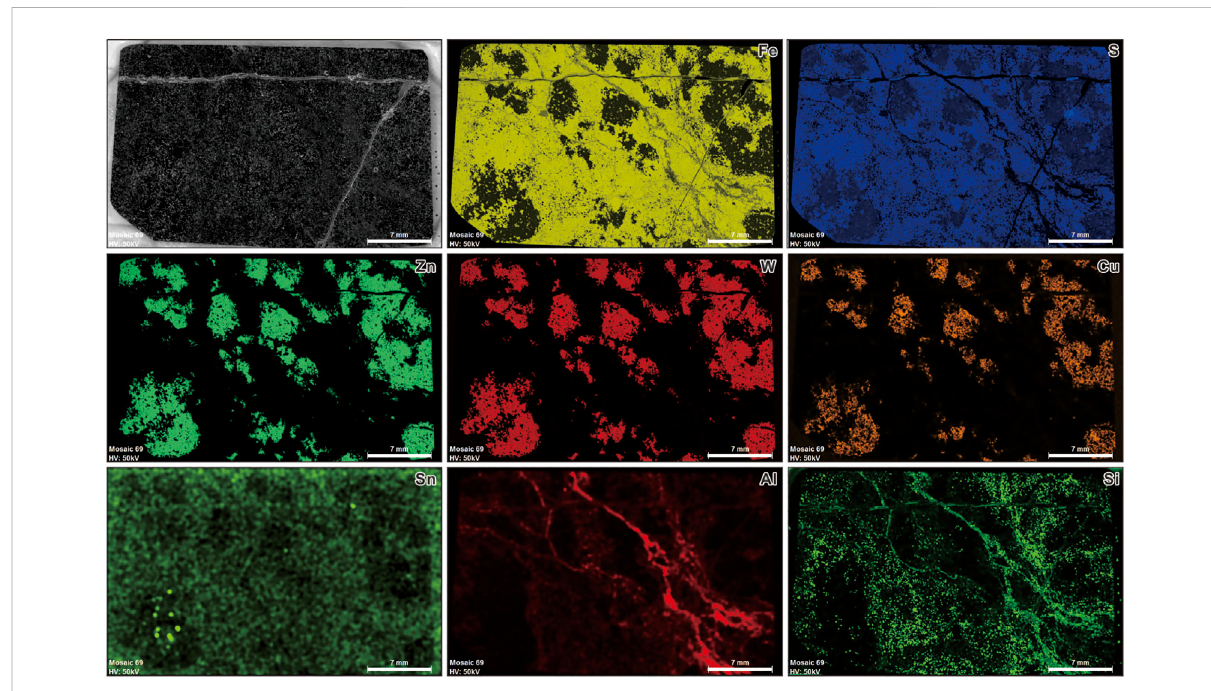
FIGURE 7 Photograph and single-element μ -XRF maps (Fe, S, Zn, W, Cu, Sn, Al, Si) of thin section